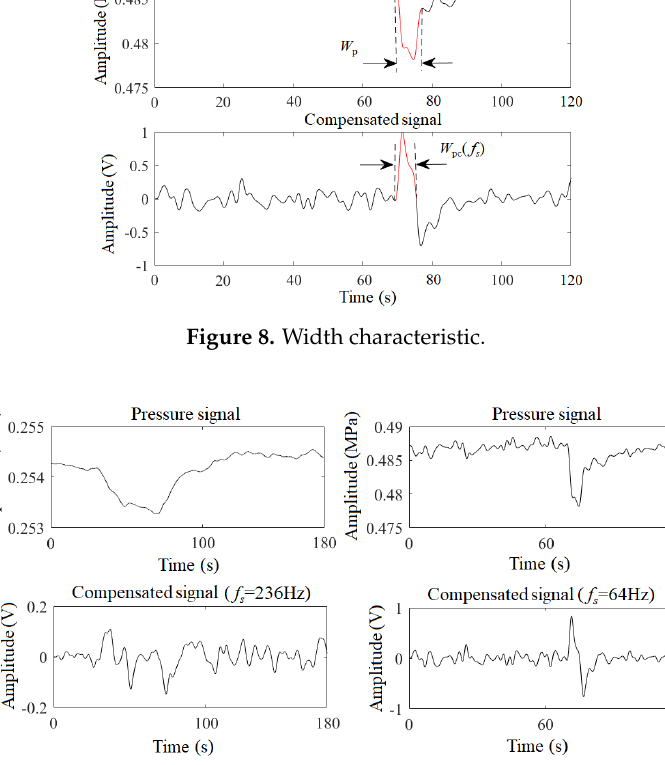
Figure 9. Pressure signals and compensated signals with the optimized f s